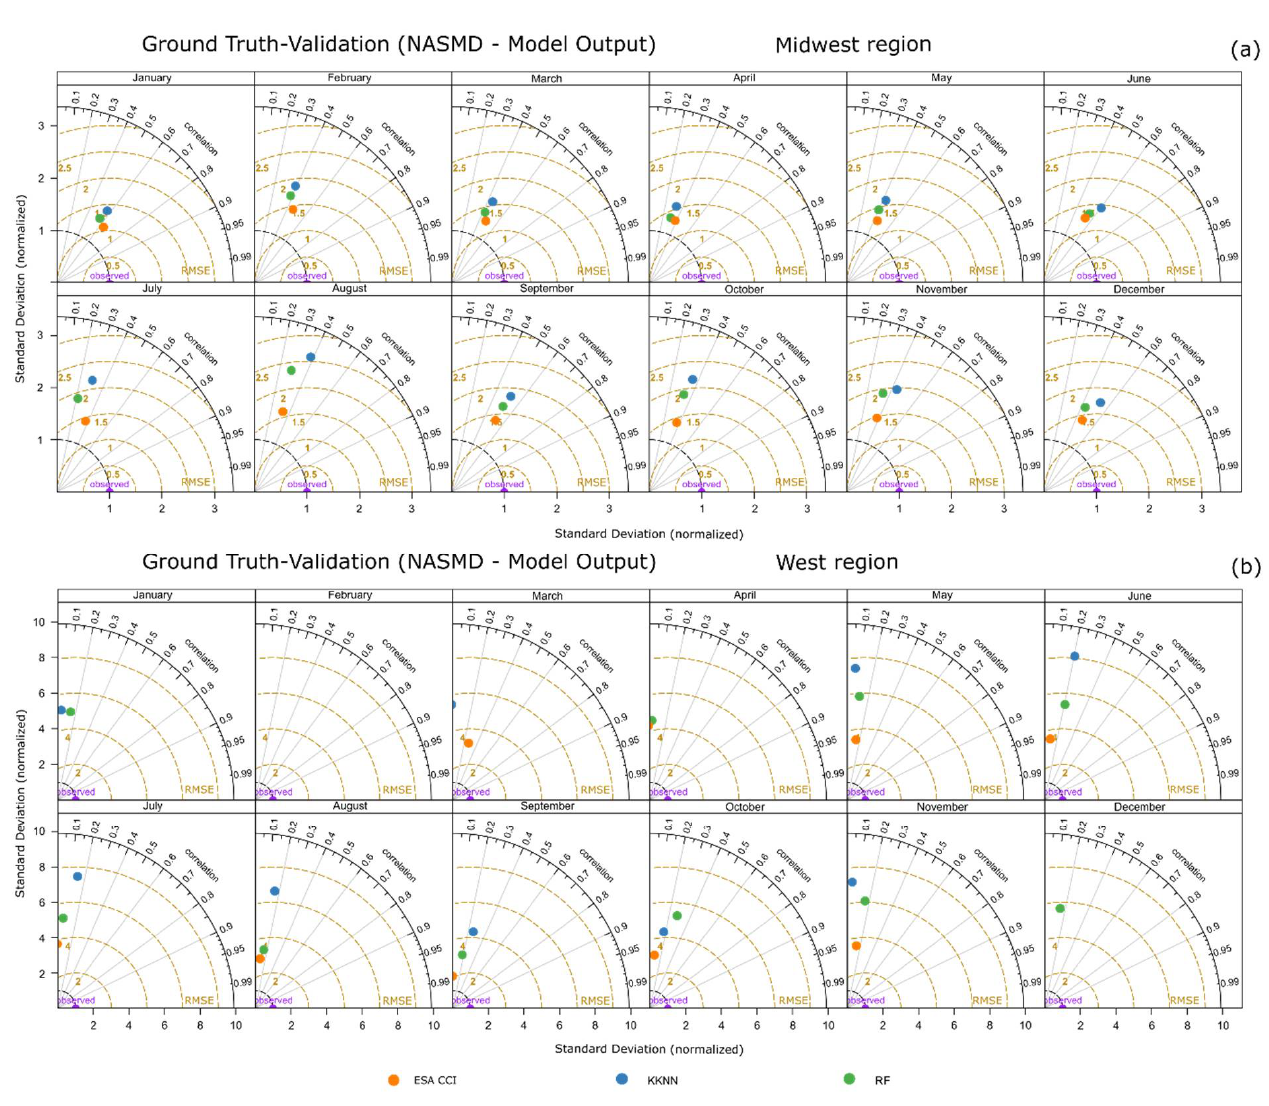
Figure 6. Taylor diagrams showing validation between monthly 1 km predicted soil moisture and ESA-CCI values, and ground-truth data from the NASMD; ( a ) monthly ground-truth validation of the Midwest ROI; ( b ) monthly ground-truth validation of the West ROI.